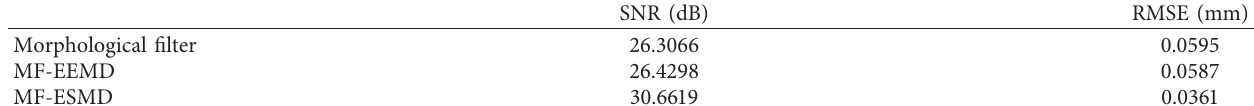
Table 2: The SNR and RMSE values of the denoised signal using the three denoising methods.